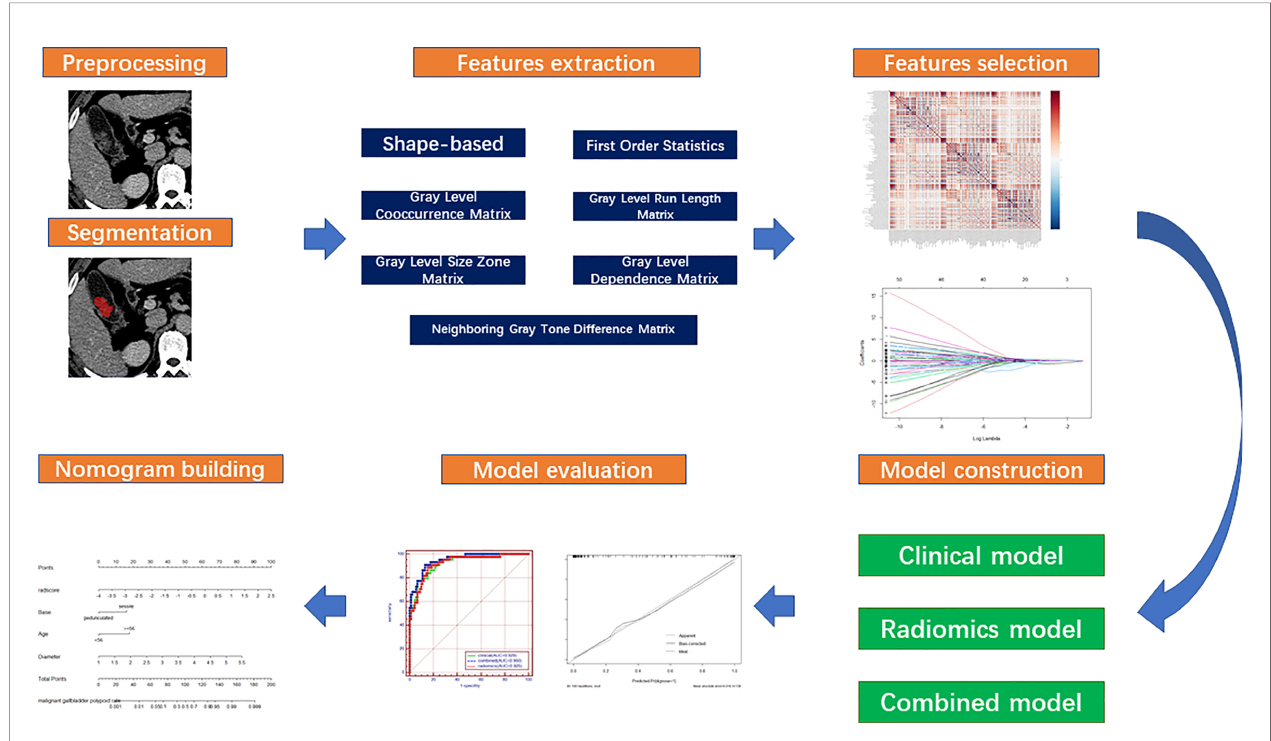
FIGURE 1 | Study work fl